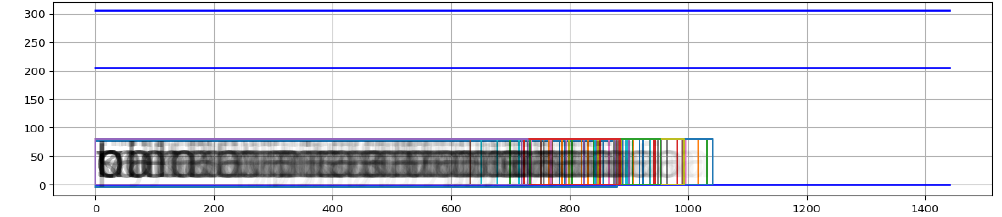
Figure 6. Text editing area and phrase set bounding